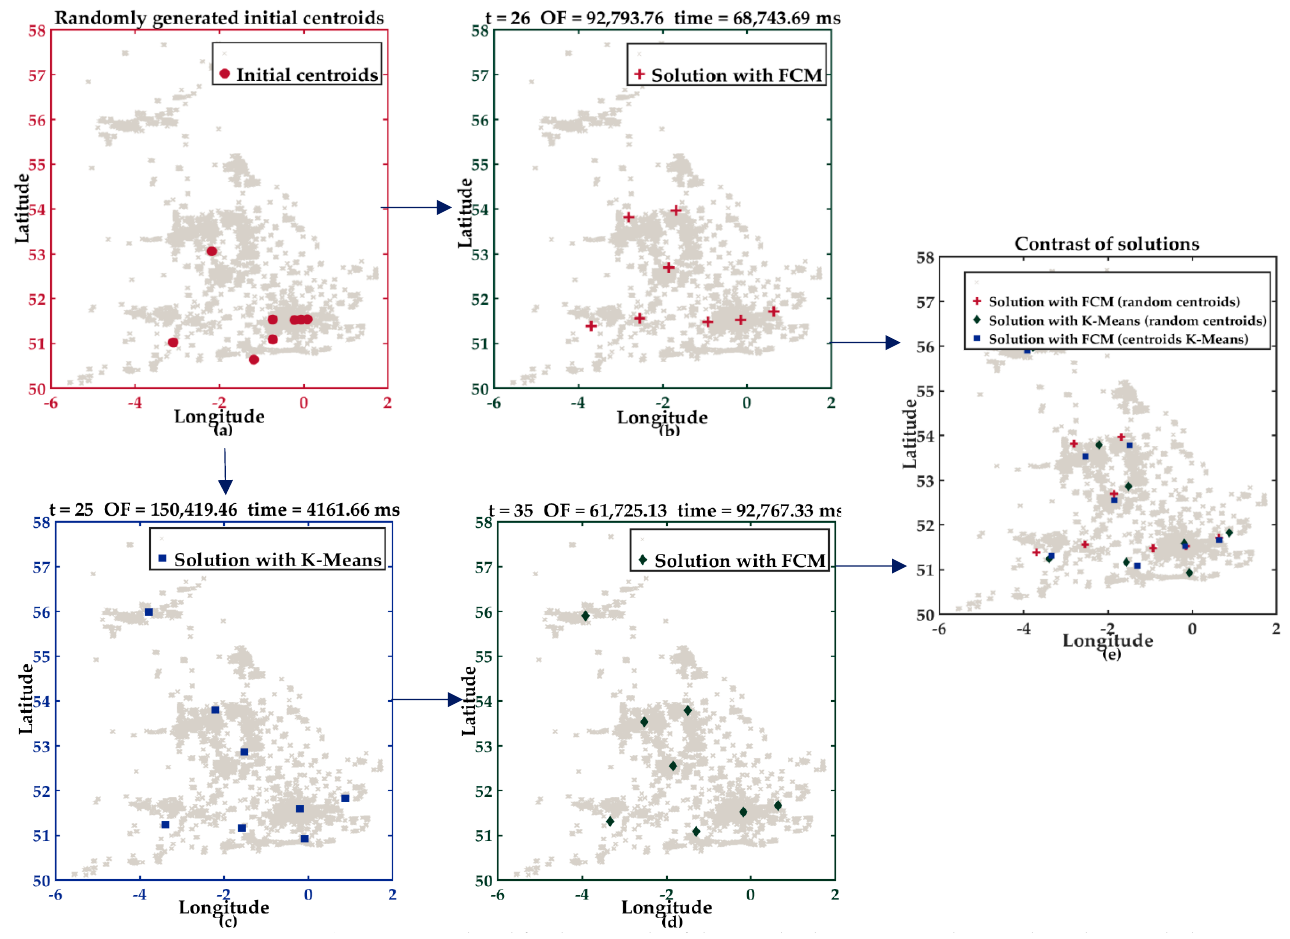
Figure 2. Initial and final centroids of the standard K-Means and FCM algorithms with the URBAN dataset in Example 2. Panel ( a ) shows the randomly generated initial centroids; ( b ) contains the final centroids with the solution of the standard FCM algorithm, considering the random initial centroids; ( c ) visualizes the final centroids with the solution of the K-Means algorithm that receives random centroids; ( d ) shows the final centroids of FCM with initial centroids generated after K-Means convergence; and ( e ) presents a comparison of solutions of the FCM and K-Means algo- rithms.